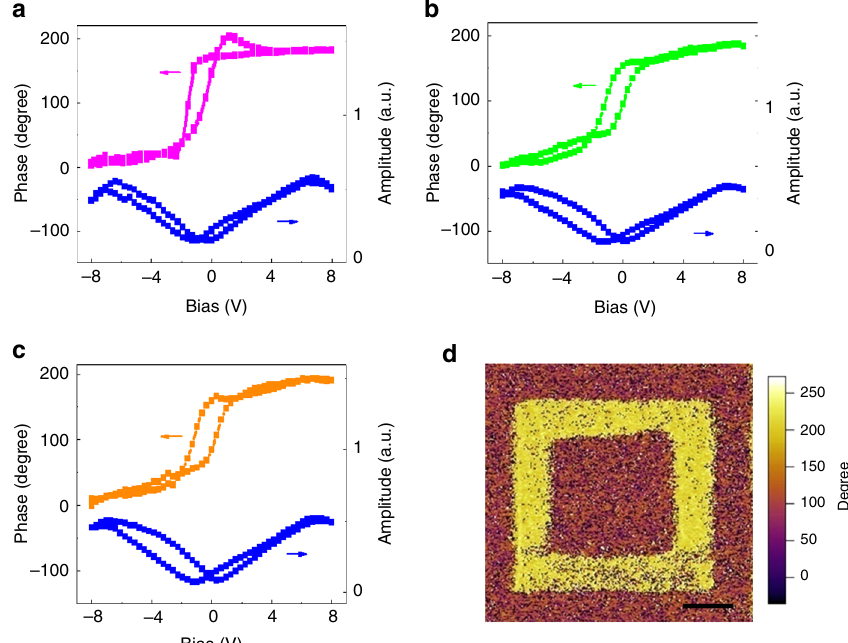
Fig. 2 Ferroelectricity in d 1T-MoTe 2 . a PFM phase hysteretic and butter fl y loops of monolayer d 1T-MoTe 2 . b , c PFM phase hysteretic and butter fl y loops of d 1T-MoTe 2 before and after 30 days. d PFM phase image of monolayer with ±8 V, scale bar, 1 μ